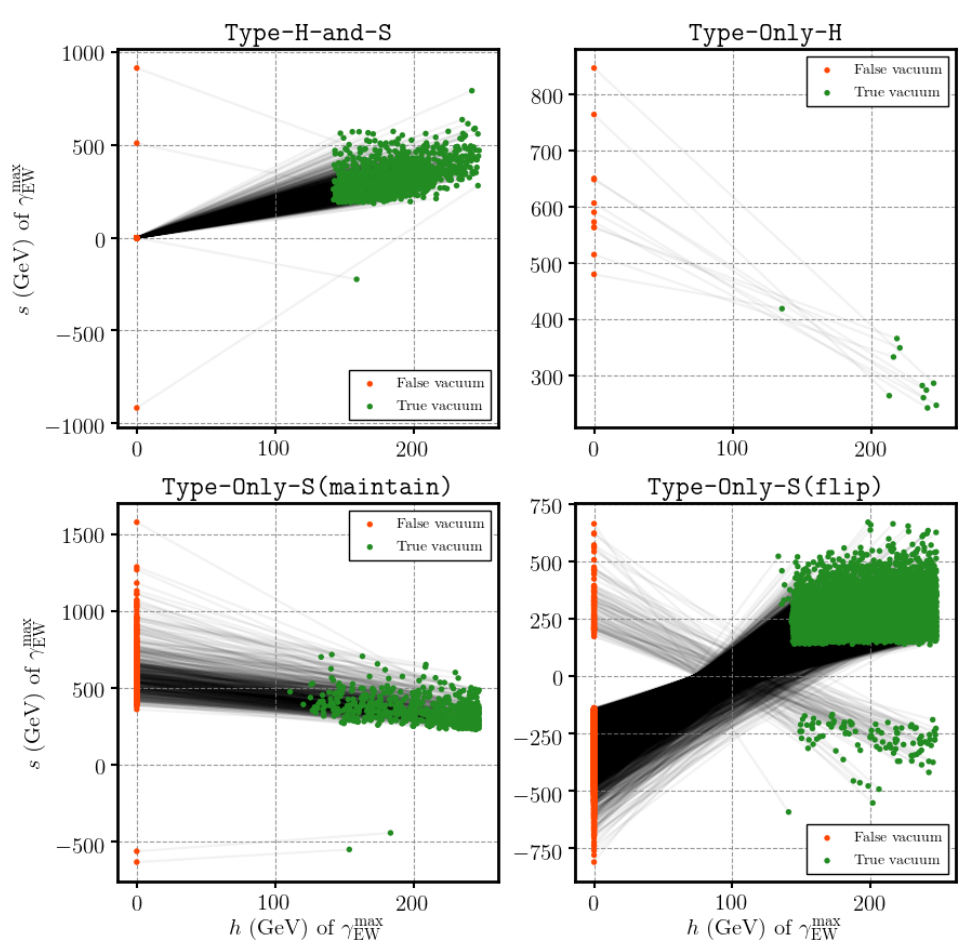
Figure 2 . The Higgs and singlet (cid:12)eld values at the true and false minima at the critical temperature of the strongest FOPT for samples for which the strongest FOPT ends in the SM